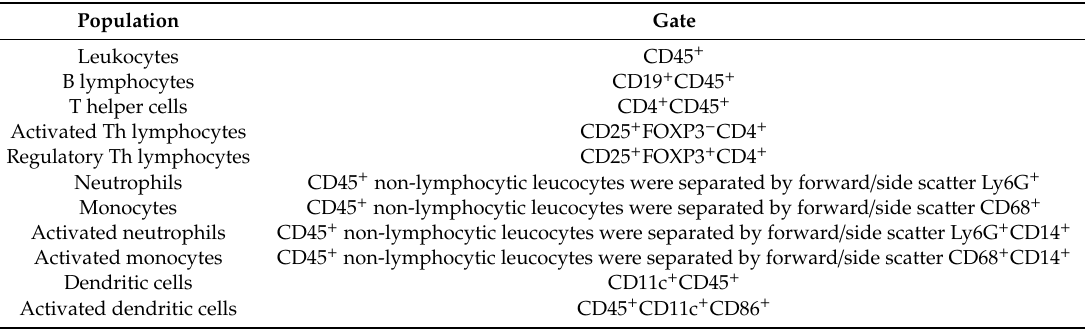
Table 5. Cell Markers to Quantify Leukocyte